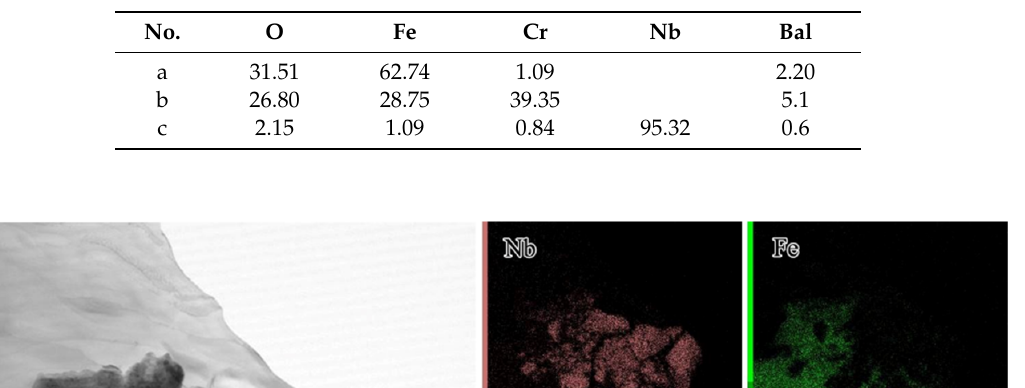
Table 2. Chemical composition (wt.%) measured (denoted in and Figure 6C) by energy dispersive spectrometer (EDS).